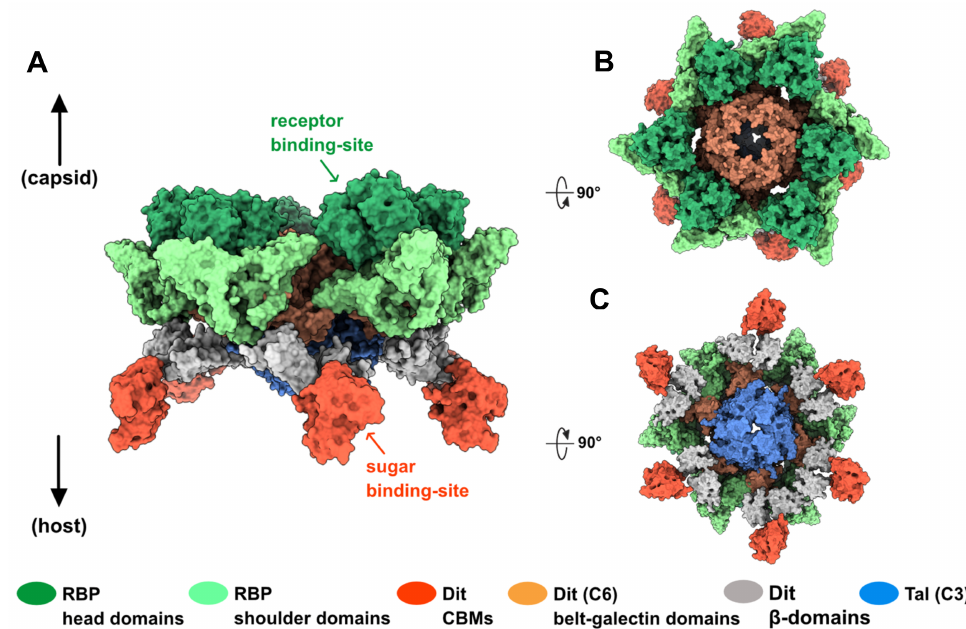
Figure 3. Topological model of the OE33PA adhesion device. ( A – C ). Orthogonal views of the adhesion device ( A ): side view; ( B ): top view; ( C ): bottom view). This model was generated from the crystal structure of the phage p2 adhesion device in its resting state with the RBP head domains pointing towards the capsid (PDB ID 2wzp). Connections between CBMs (red) and their flanking β -domains (grey) are not represented. The color code is